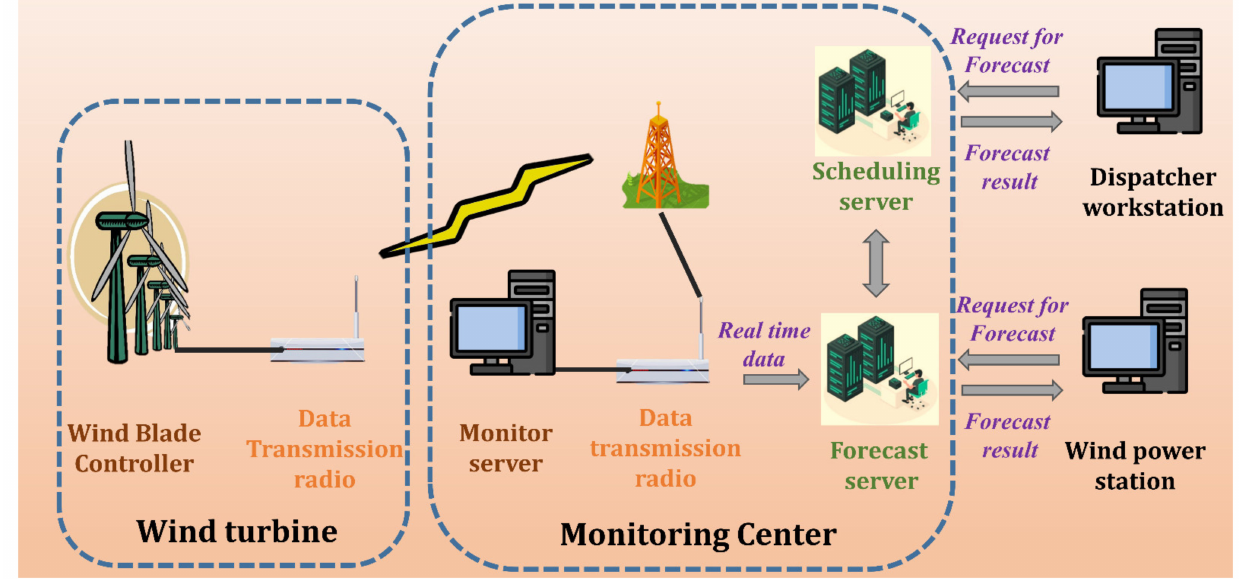
Figure 5. IoT-based wind power monitoring